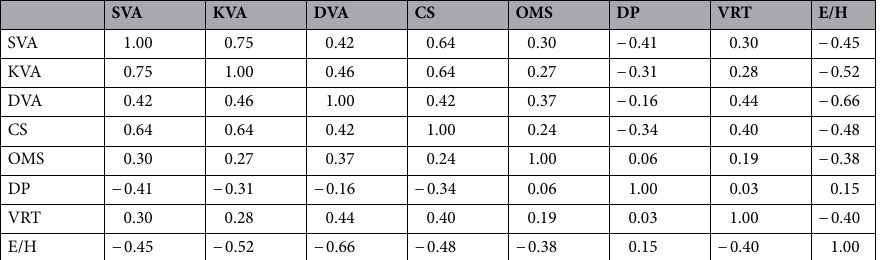
Table 2. Correlation coefficients among the eight tests. Abbreviations: SVA: static visual acuity, KVA: kinetic visual acuity, DVA: dynamic visual acuity, CS: contrast sensitivity, OMS: ocular motor skill, DP: depth perception, VRT: visual reaction time, E/H: eye hand